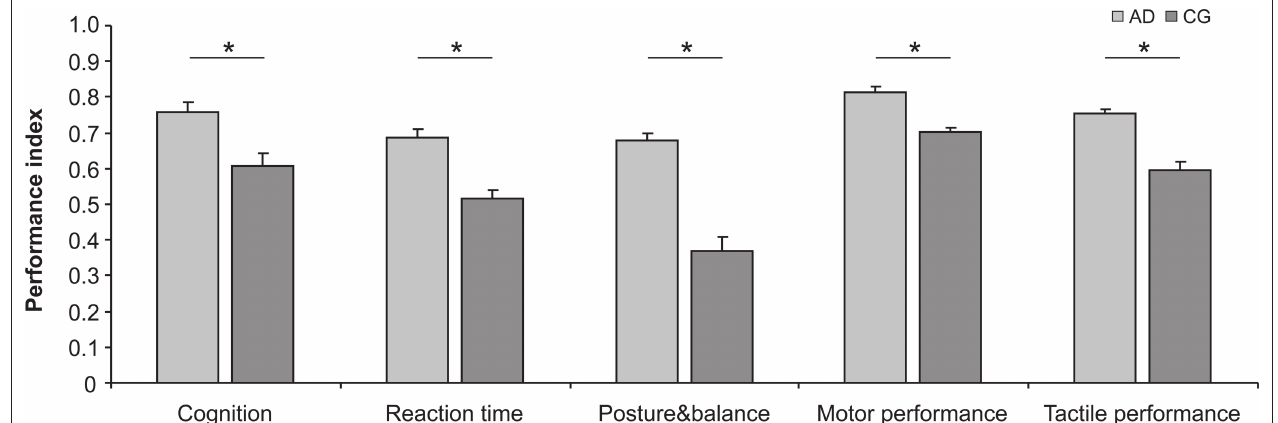
FiGuRE 2 | Average indices of performance (iP) characterizing cognition, RTs, posture&balance as well as motor and tactile performance. Higher indices were found for the AD group in all domains, with largest advantages for posture and balance. In all cases, performances of the left and right hand were pooled. “Cognition” ( p = 0.010) comprises RSPM and AKT. “Reaction times” ( p = 0.003) were averaged for all fingers and for the left and right hand.